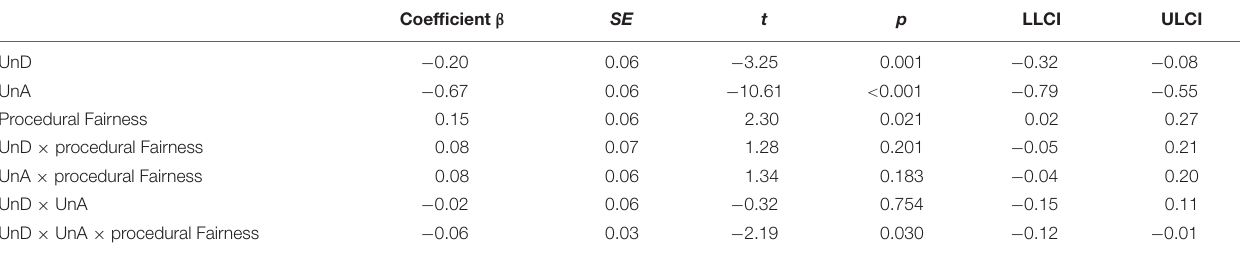
TABLE 3 | Effects of the moderated regression analysis including procedural fairness (Hayes, 2013, Model